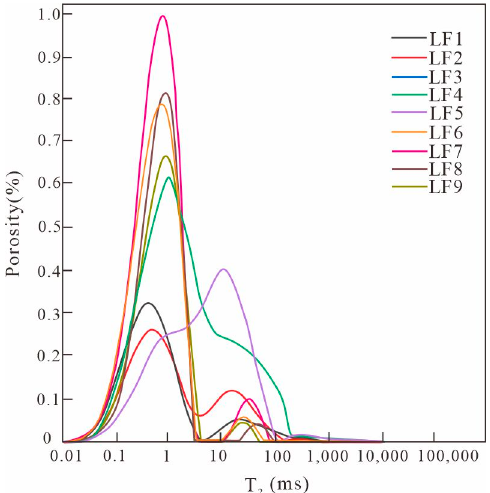
Figure 8. The NMR T 2 spectra of the nine lithofacies in Es4s Dongying Depression.